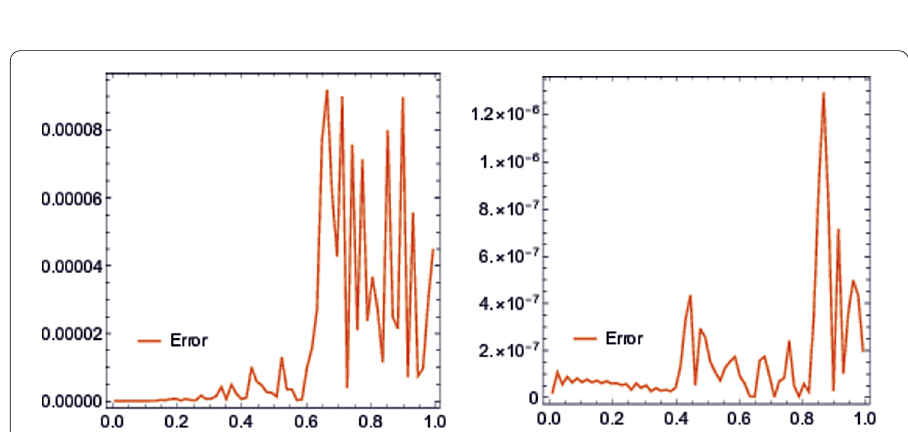
Figure 7 Comparison of the exact and approximate solutions of Example 4.2 for m =